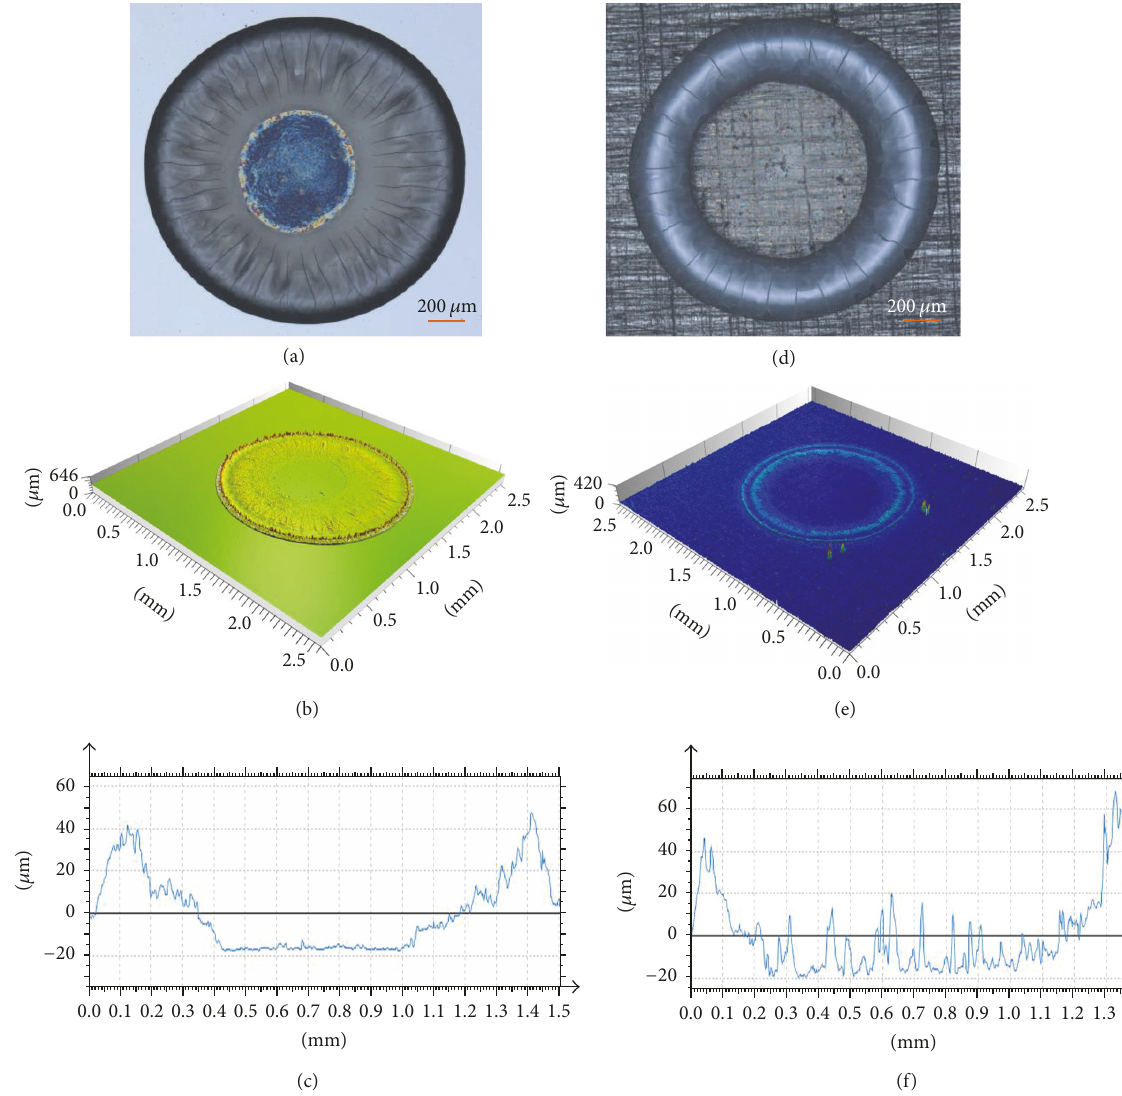
Figure 2: Evaporation patterns of PTFE colloidal droplets and their profiles on different substrates: (a)–(c) smooth substrate, (d)–(f) rough